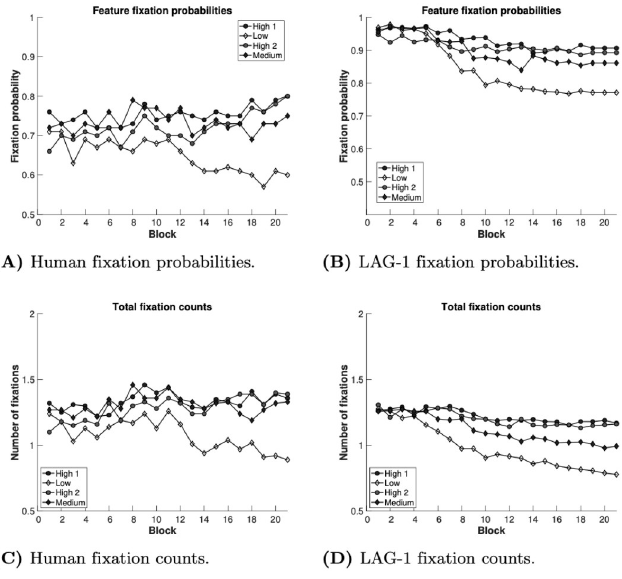
Fig 11. Simulation 2: Fixation proportion fits. The fixation proportions aggregated across just the transfer trials of the experiment. LAG-1 data is on the left, while the data from [10] are re-represented on the right.